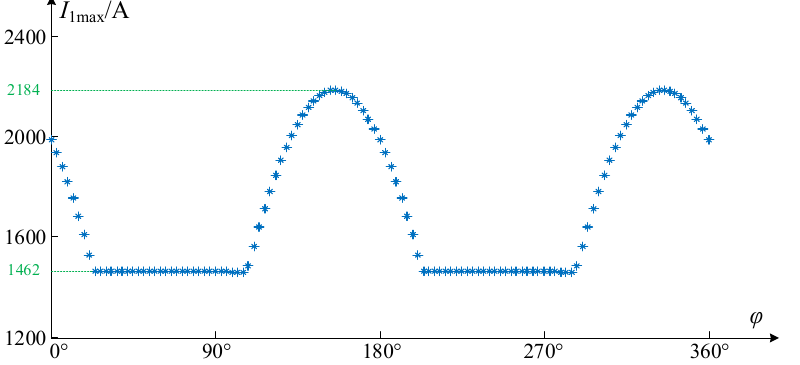
Figure 6. Maximum value of the wind turbine’s output current after the fault with different grid voltage phases, φ .